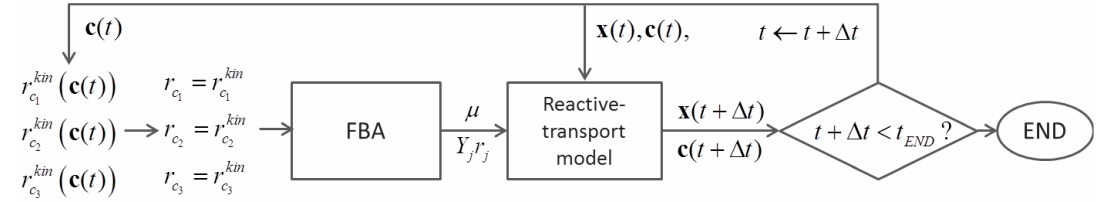
Figure 13. Implementation of direct coupling between FBA and a reactive-transport